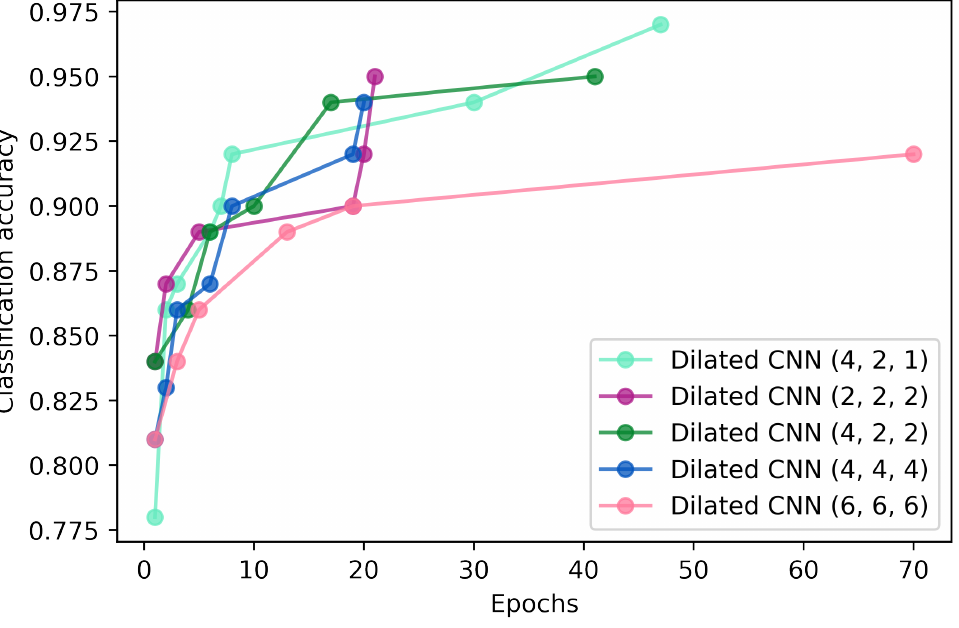
Figure 6. Comparative analysis of various dilation rate parameters based on the maximum validation (classification) accuracy achieved during